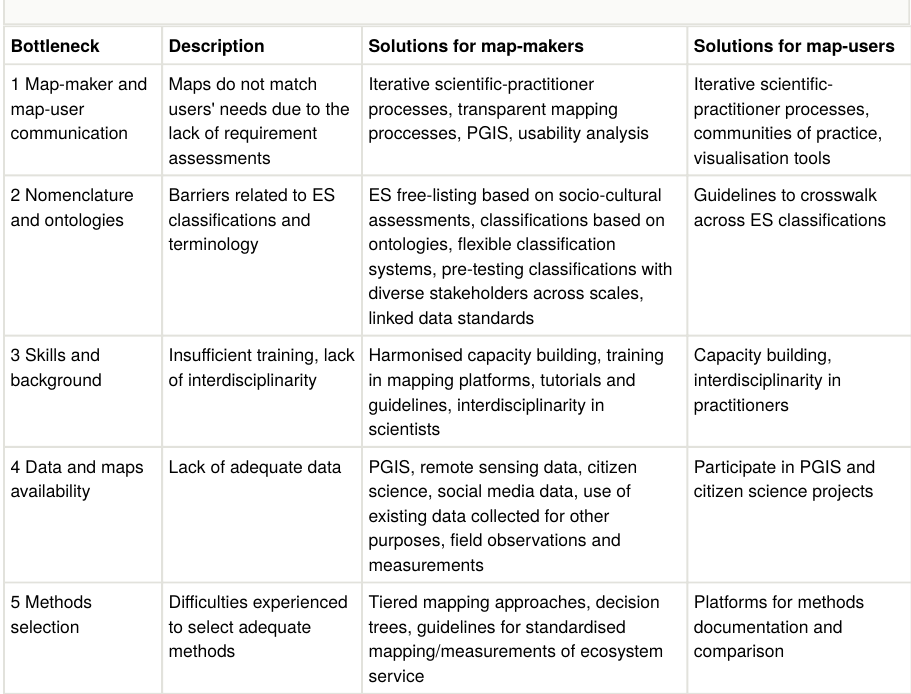
Ecosystem services (ES) mapping bottlenecks and solutions o ff ered around